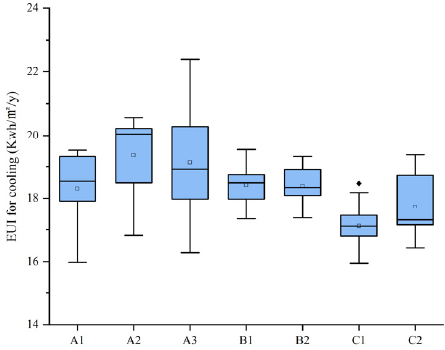
Figure 17. Distribution characteristics of EUI for cooling in different typologies of office blocks.